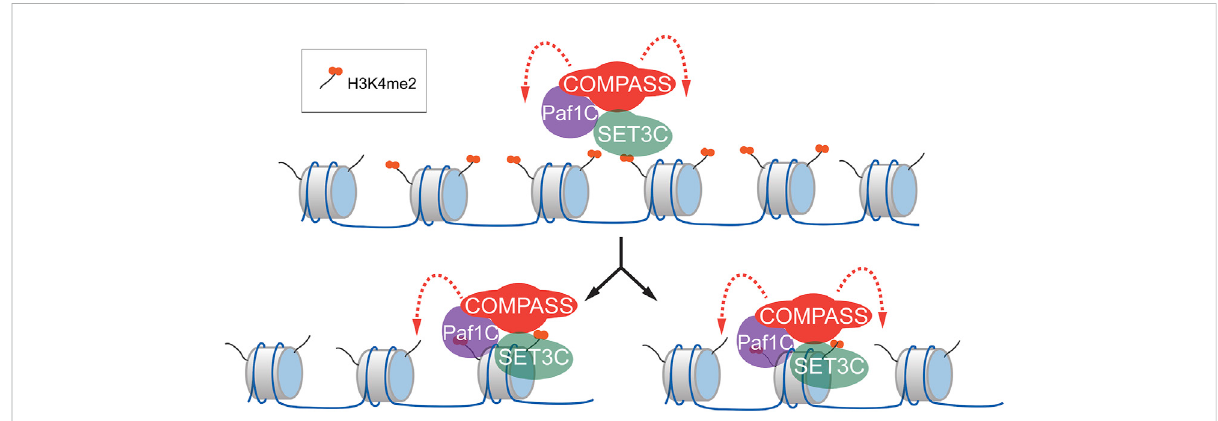
FIGURE 2 Model for the mechanism of inheritance of H3K4me2 during epigenetic transcriptional memory. During memory, H3K4me2 is both protected from demethylation by SET3C and, through interaction with COMPASS, SET3C H3K4me2 is maintained (top). Following DNA replication (bottom), H3K4me2-modi fi ed nucleosomes are reincorporated locally, along with unmodi fi ed nucleosomes. SET3C binding of H3K4me2 through its PHD domain facilitates recruitment of COMPASS/PAF1C, which demethylates unmodi fi ed nucleosomes